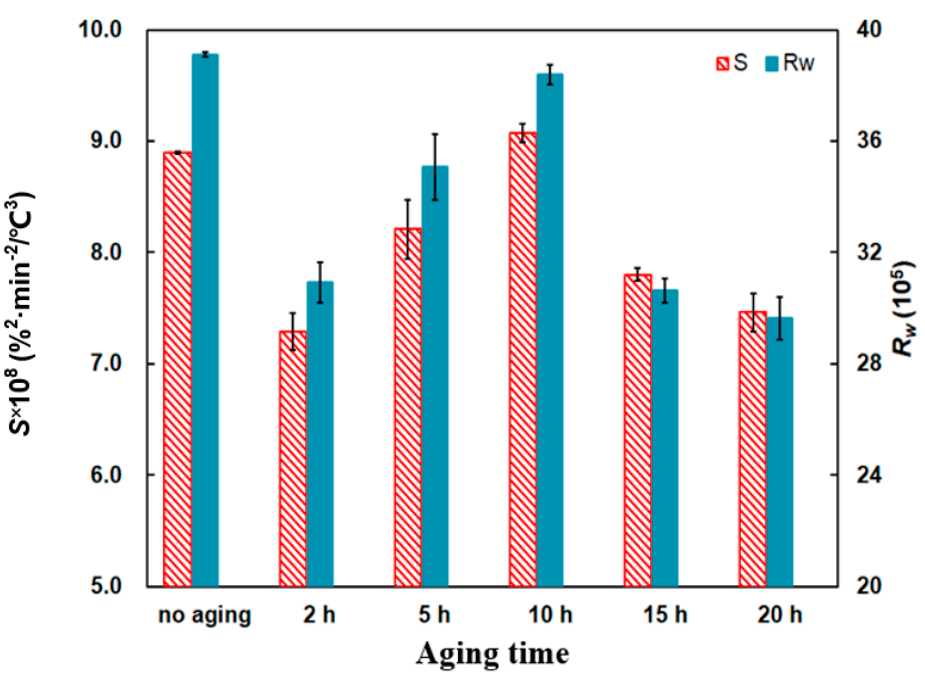
Figure 14. Comparison of the S and R w indices at different thermal aging times.